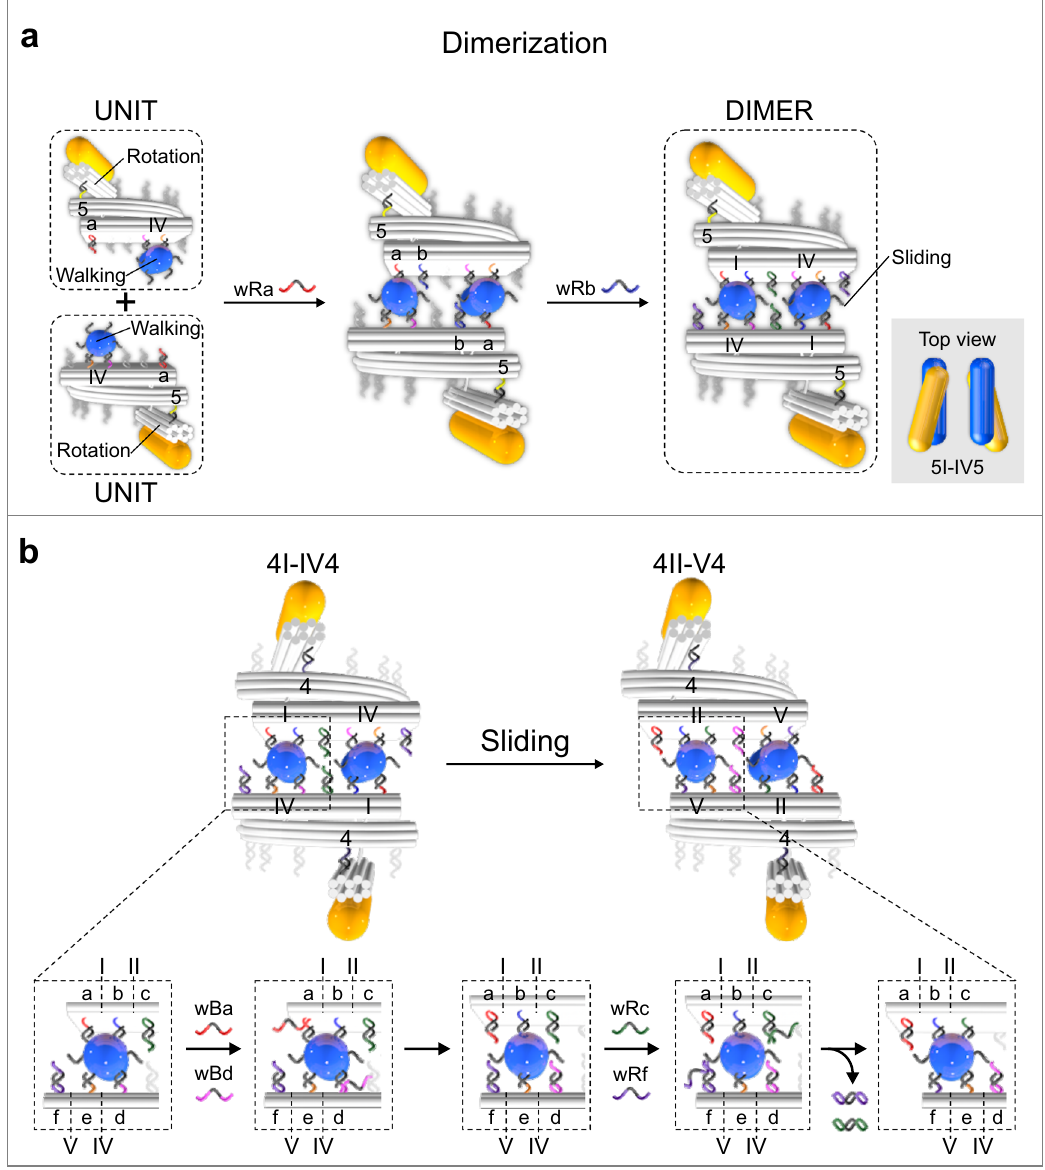
Fig. 3 Dimerization of the UNITs. a Schematic of the dimerization of the UNITs at state IV5. Wfha in the UNITs is activated through the addition of wRa. The interaction between wfha in one UNIT and the walker AuNR in the other UNIT leads to the crosslinking of the two UNITs in an antiparallel fashion, forming a DIMER. Wfhb is activated by wRb to stabilize the DIMER at state 5I-IV5. The two walking modules are merged into a sliding module. Inset: top view of the AuNRs in the DIMER at state 5I-IV5. b Working principle of the coordinated sliding from state 4I-IV4 to three states in different views. The side views show linear-like structures in various lengths, resulting from different degrees of oligomerization (see Supplementary Fig. 15). Circular structural pro fi les in different diameters (d) are observed in the top views.